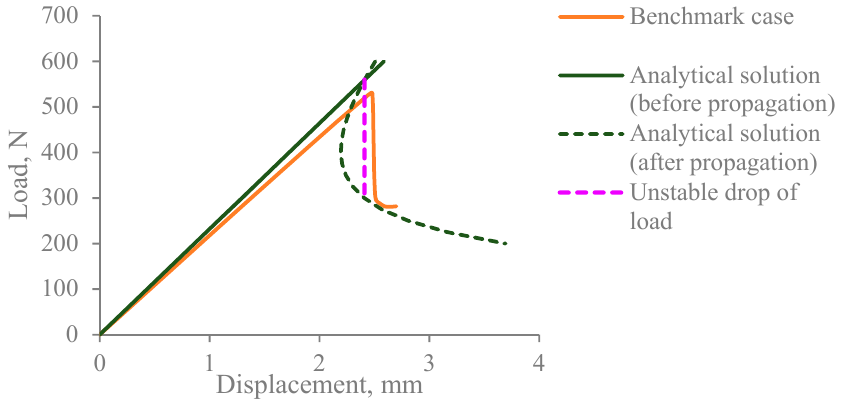
Figure 14. Comparison of the converged solution for Mode II obtained via FE modelling with an analytical solution from [32].